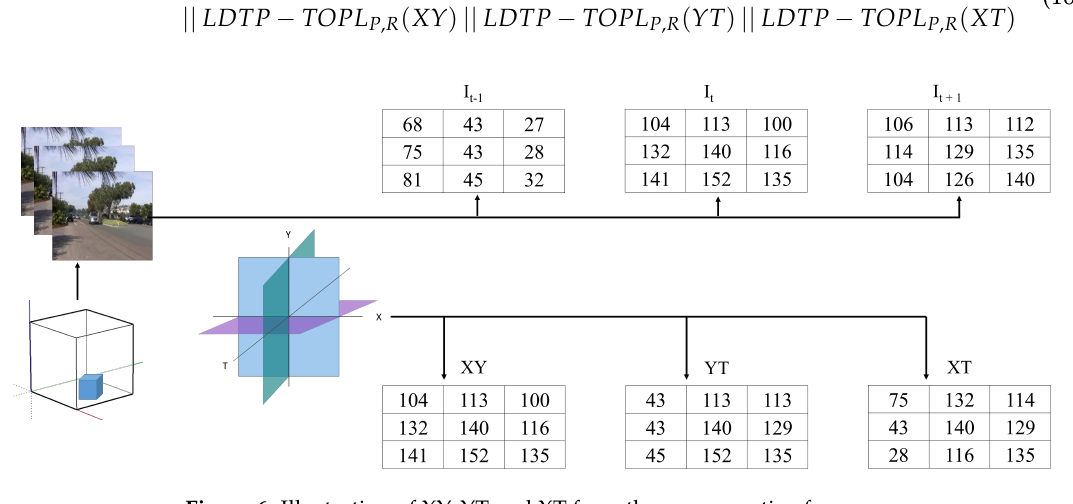
Figure 6. Illustration of XY, YT and XT from three consecutive frames.